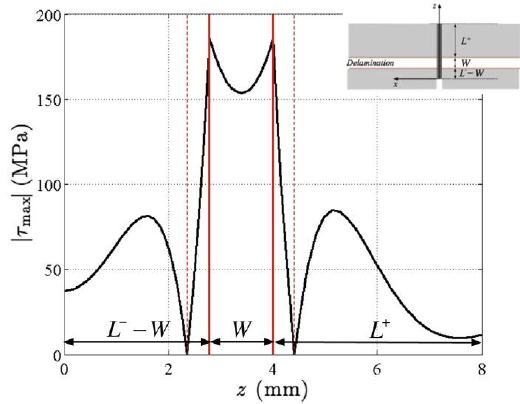
F igure 28. Predicted maximum shear stress distribution along the z-Pin for